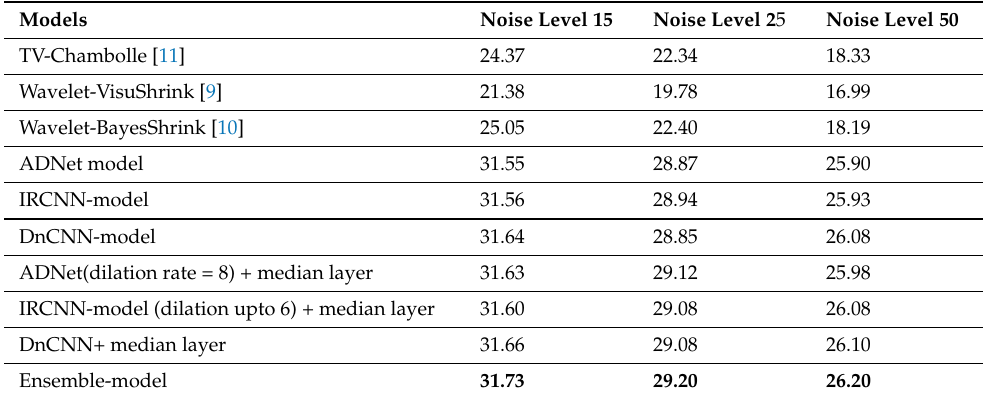
Table 1. Average PSNR values of images predicted by the image denoising models on the images of BSD500 dataset.